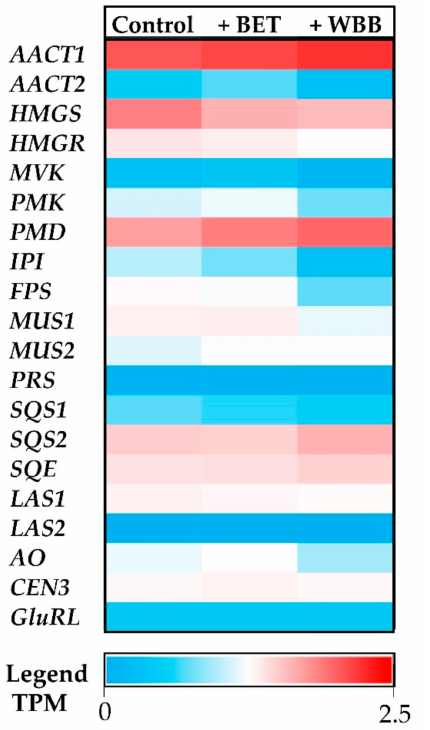
Figure 7. Heatmap of the digital expression levels of transcripts encoding terpenoid biosynthetic enzymes in the Inonotus obliquus transcriptome. Results are in transcripts per million (TPM) with the legend from low (blue) to high (red) expressed